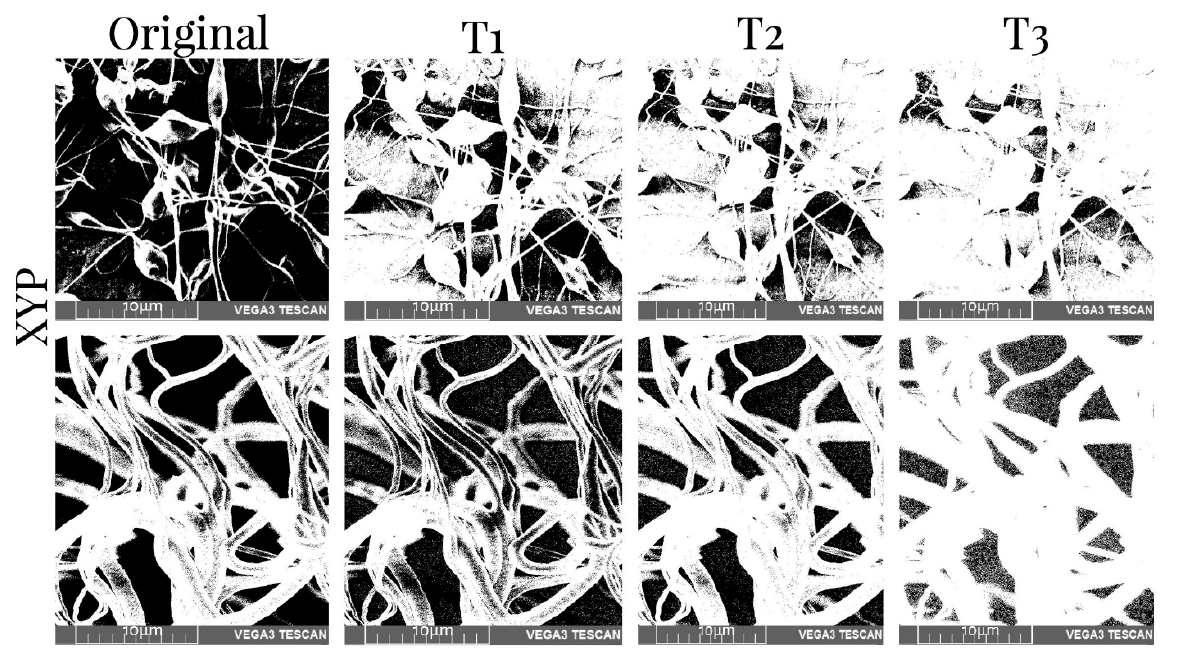
Figure 6. SEM images of the obtained RC45 scaffolds and binary images with three thresholds before (top row) and after mechanical tests (bottom row). T1–T3: threshold 1–3.